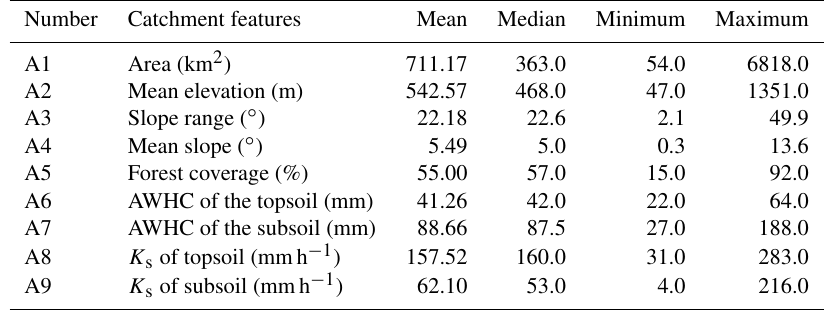
Table 2. Summary of the characteristics of the 145 catchments that had prolonged meteorological drought, including the mean, median, minimum, and maximum estimates of nine catchment features.